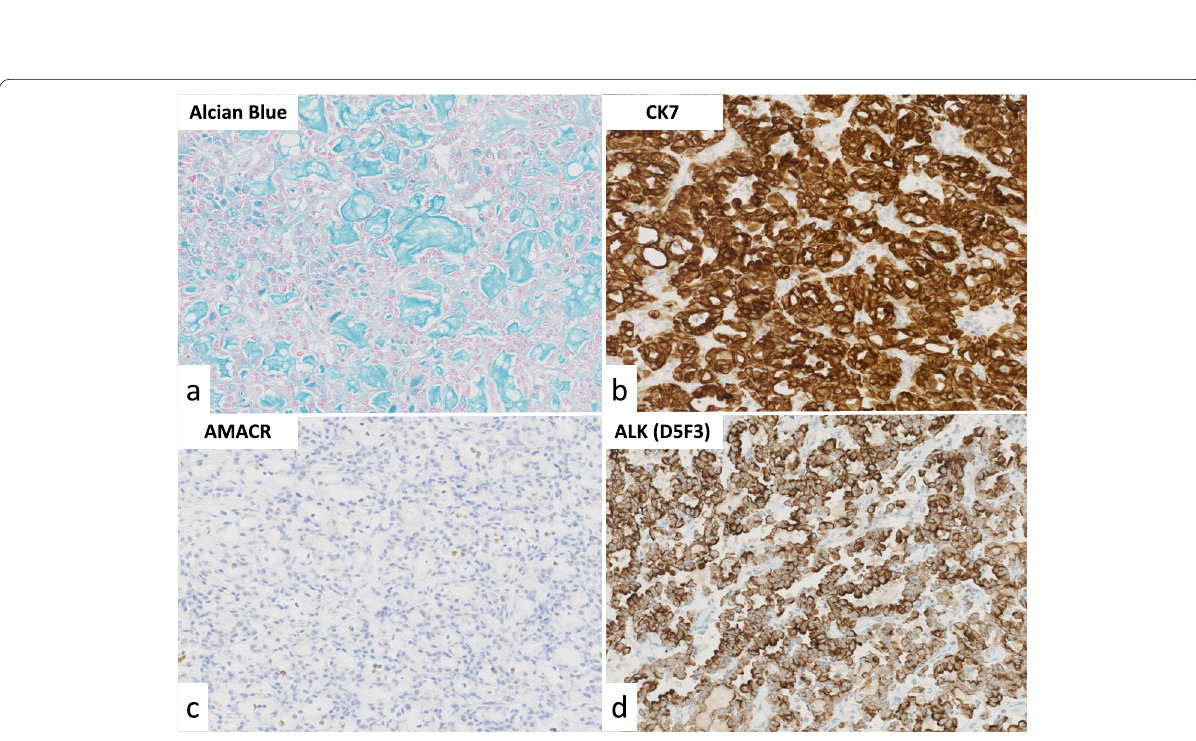
Fig. 3 a Extracellular mucin deposition is highlighted by alcian blue staining). IHC results for CK7 (b) , AMACR (c) , and ALK(D5F3) (d ). The magnification of all four slides is 200. The tumor showed diffuse positivity at the cytoplasm and diffuse and strong positivity at the cell ×